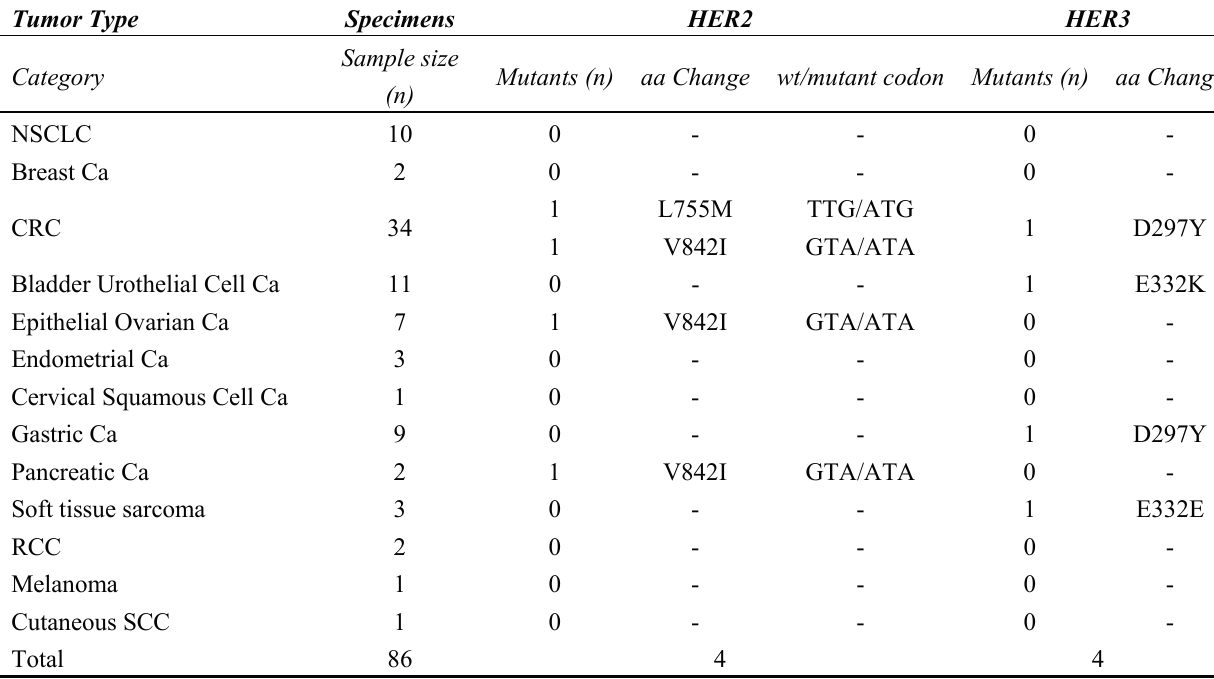
Table 1. Tumor type description and mutational profile of the samples included in the study. Tumor